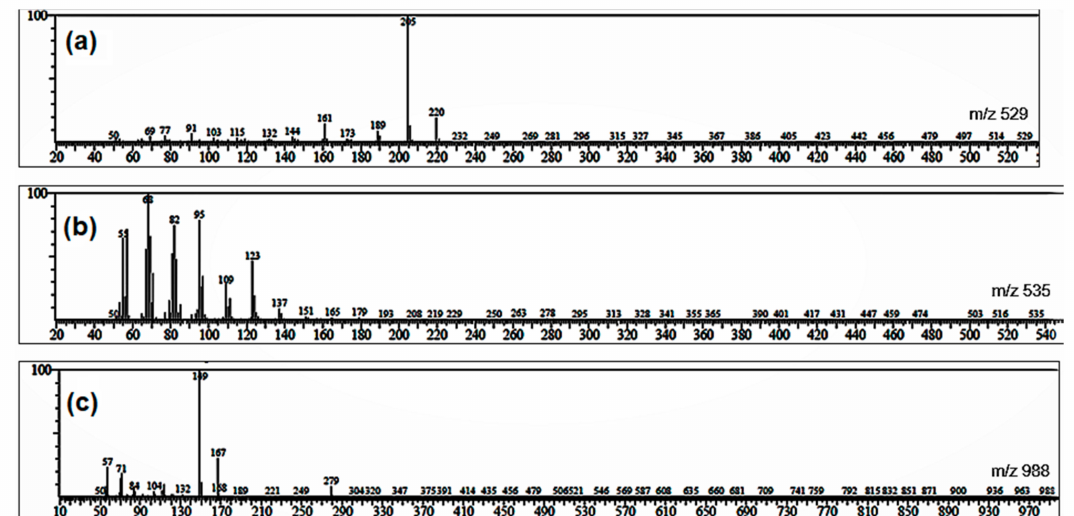
Figure 12. The mass spectra of three peaks identified from GC chromatogram of ( a ) AC n -hexane, ( b ) IC n -hexane, and ( c ) IC ethylacetate. The base peak informs the most stable fragment during electron impact in MS characterization.